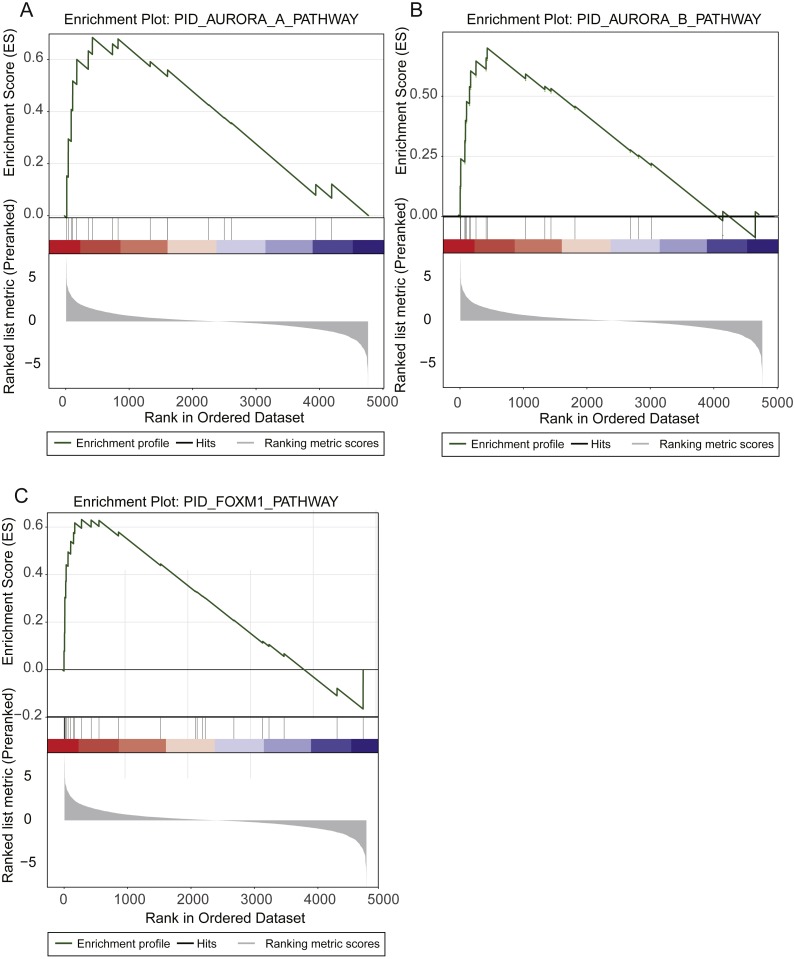
Prognostic pathways identified by gene set enrichment analysis (GSEA).The enrichment plots for Aurora-A signaling, Aurora-B signaling, and FOXM1 transcription network were illustrated in (A), (B), and (C).